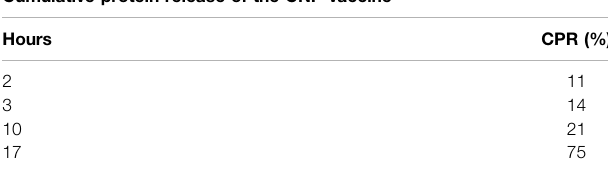
TABLE 4 | The pH stability assay and cumulative protein release assay of the synthesized CNP vaccine. The CNP were incubated in 1 × PBS at 7.4 pH and the cumulative antigen release was assessed at different time points. Means +SD. n = 2.